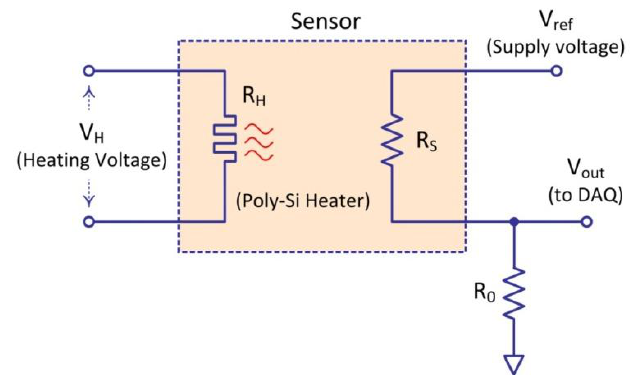
Figure 4. Potentiometric circuit conditioning of the gas sensor.